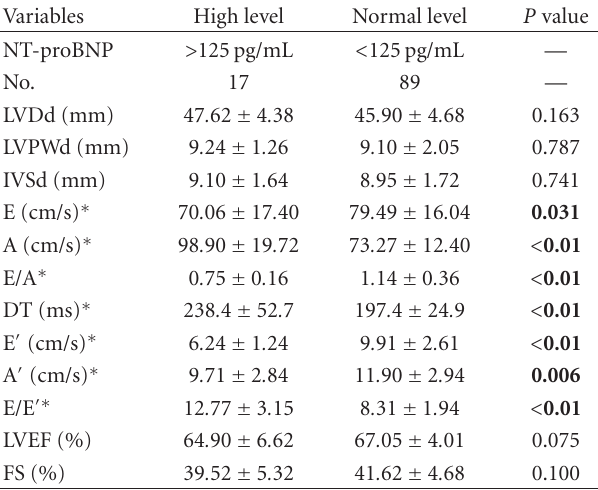
Table 3: Echocardiographic features of patients with di ff erent serum NT-proBNP